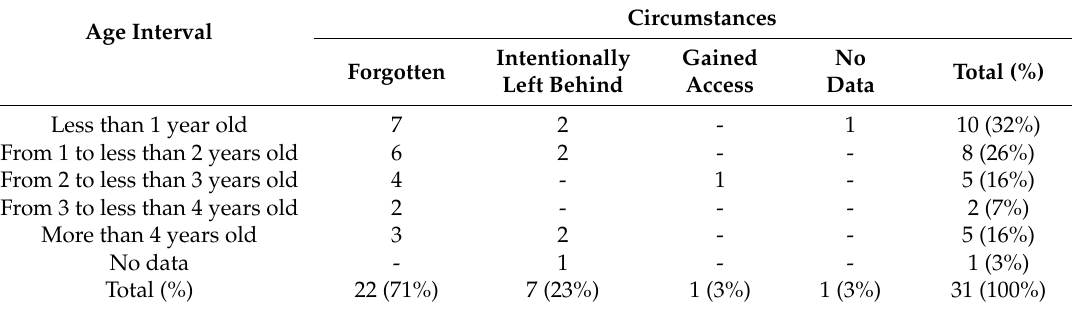
Circumstances Intentionally Gained No Total (%) Forgotten Left Behind Access Data